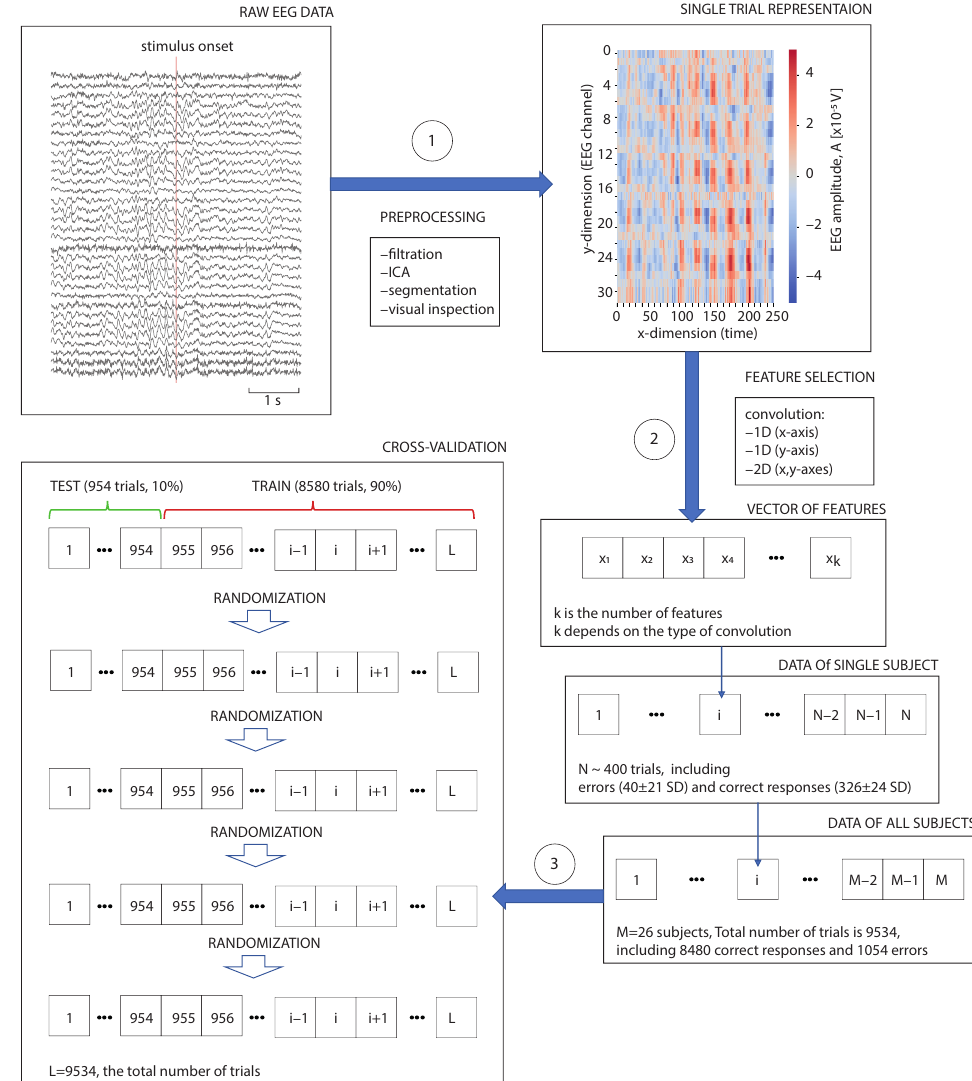
Figure 2. Schematic illustration of the overall data analysis framework with three main steps: preprocessing (1), feature selection (2), and cross-validation